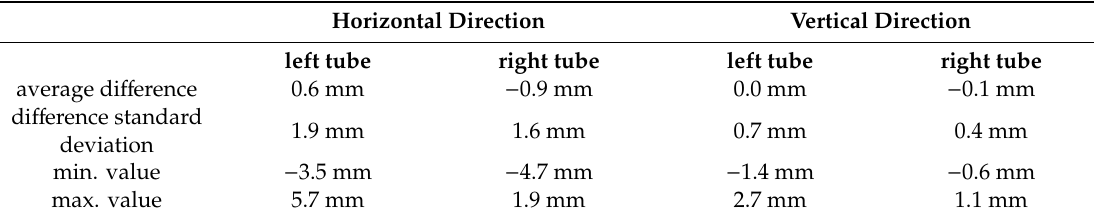
Table 2. Statistics on the di ff erences between both methods (single- and multi-prism) for both inrun tubes (left and